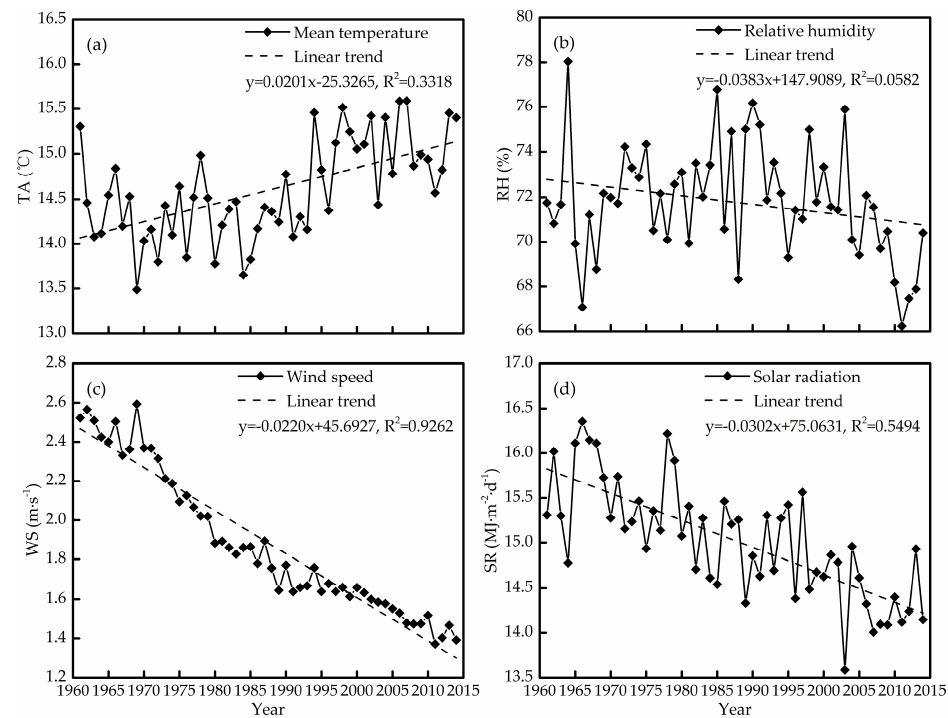
Figure 2. Box plots show the monthly variations of ( a ) TA ; ( b ) RH ; ( c ) WS ; and ( d ) SR in the HRB.